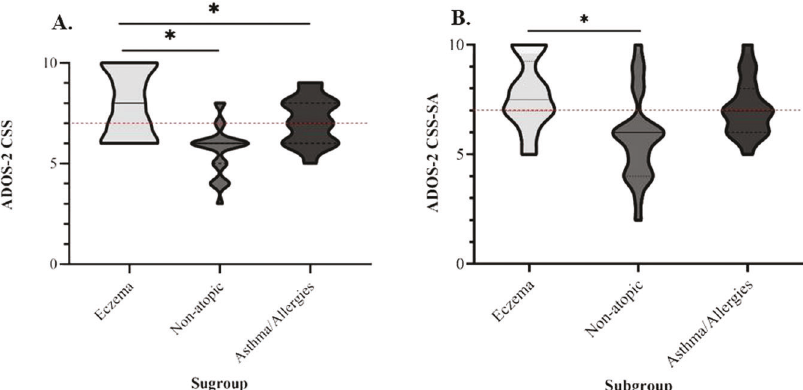
Fig. 2 Distribution of ADOS scores in the eczematic ( n = 26), non-atopic ( n = 24) and asthma/allergies ( n = 17) subgroups. Children with comorbid eczema scored signi fi cantly higher on the A . ADOS-2 CSS relative to those in the non-atopic subgroup ( p < 0.001), and those in the asthma allergies group ( p = 0.034 using one-tailed test; p = 0.069 using two-tailed test). B Children with comorbid eczema scored signi fi cantly higher on the ADOS-2 CSS-SA relative to those in the non-atopic subgroup ( p = 0.001) yet no differences were observed relative to the asthma/allergies cohort ( p = 0.197). All p values were determined using bootstrapped Welch two independent-sample t -tests. * p < 0.05. The black solid lines represent the median and the black dotted lines represent the quartiles. The horizontal red dotted line represents the threshold for severe ASD-related symptomatology of the ADOS (CSS = 7 or above). The width of the curves corresponds to the frequency of each ADOS